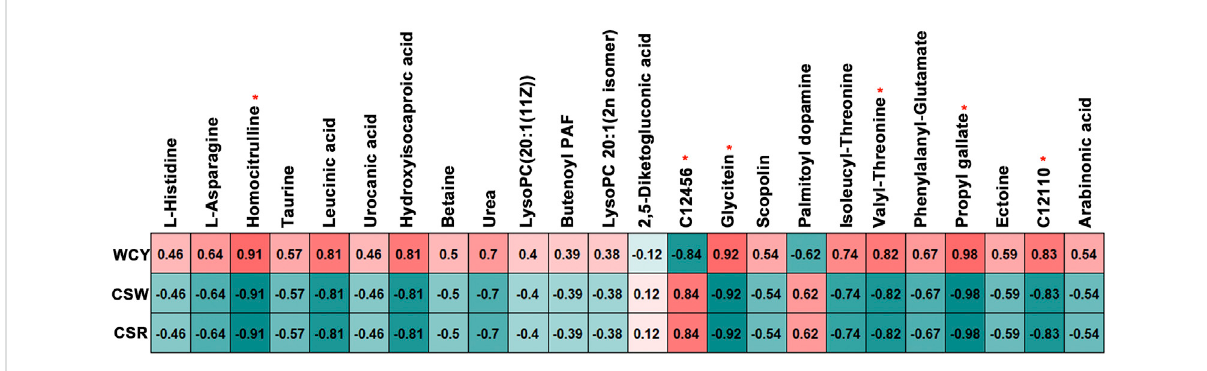
FIGURE 7 Correlation results between the cocoon yield performance traits and the six biomarkers identi fi ed. The red “ p ” indicates biomarkers which was signi fi cantly correlated with the cocoon yield performance traits. WCY, whole cocoon yield; CSW, cocoon shell weight; CSR, cocoon shell